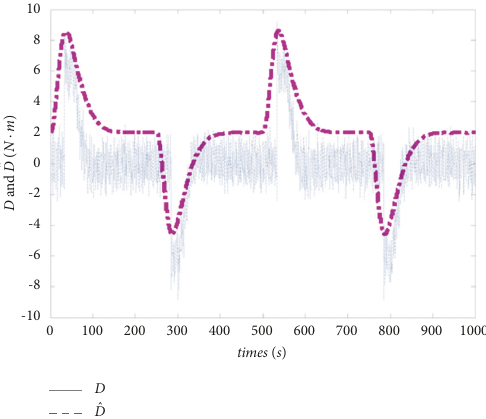
Figure 6: The results of approximation of environmental disturbances in the